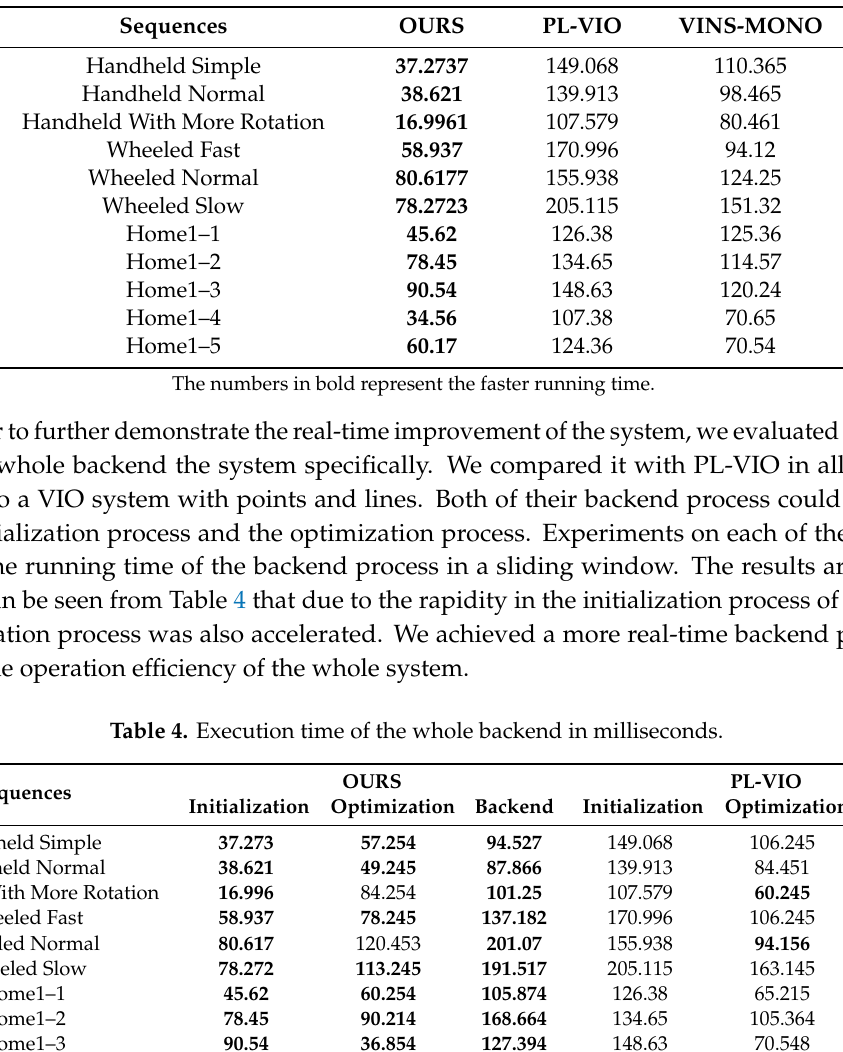
Table 3. Execution time of the initialization in milliseconds.